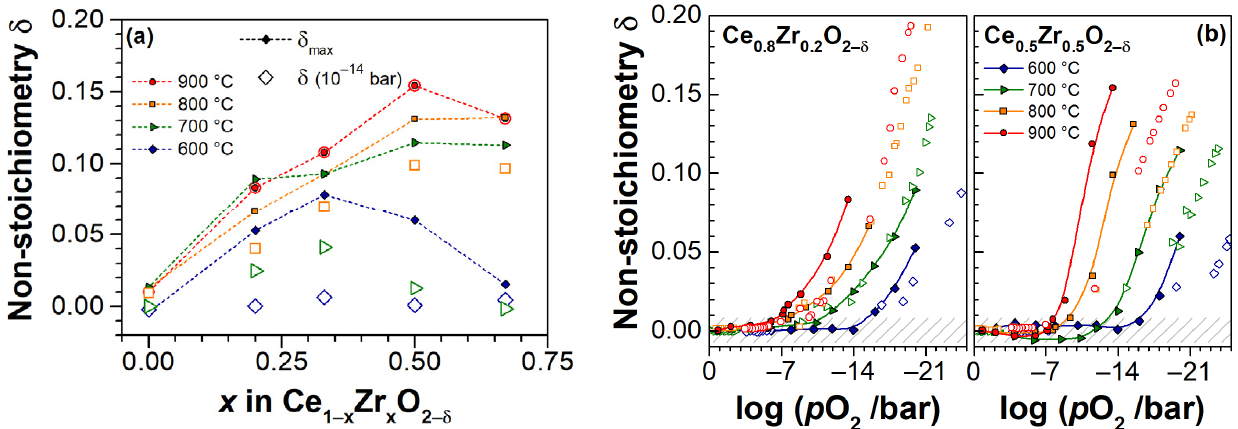
Figure 7. Non-stoichiometry as a function of Zr fraction x in Ce 1 − x Zr x O 2 − δ : ( a ) maximum non-stoichiometry δ max (solid symbols, dashed lines), and δ at p O 2 = 10 − 14 bar (open symbols); ( b ) comparison of non-stoichiometries for thin film CZO (solid symbols and lines) with δ of bulk CZO from Kuhn, et al. [9] (open symbols). The gray-dashed area depicts the uncertainty range for δ of thin films around δ = 0. isotherm are shown together with non-stoichiometry data in Figure 8 in order to observe the correlation between these two quantities. The dotted thin lines with slopes of − 1/4, 1/ n -relations. − 1/5 and − 1/6 serve as guides for eyes to follow the ( σ , δ ) vs. ( p O 2 )